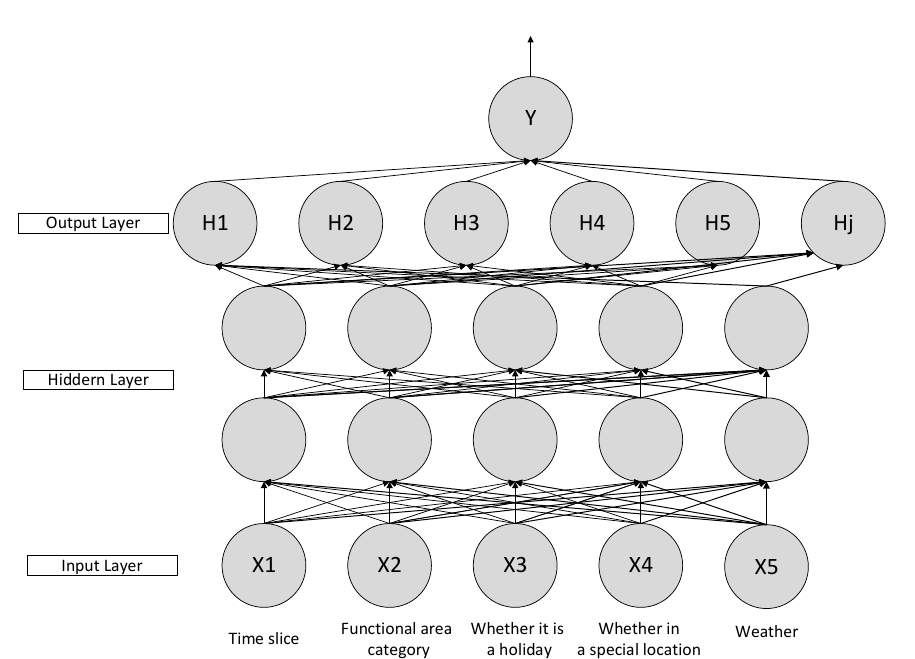
Figure 6. Topological structure of the neural network.